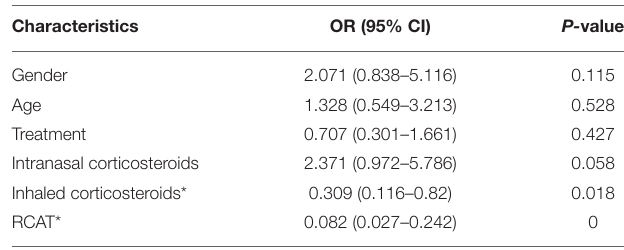
TABLE 4 | Multivariate logistic regression analysis with an ACQ-5 score ≥ 0.75 as the